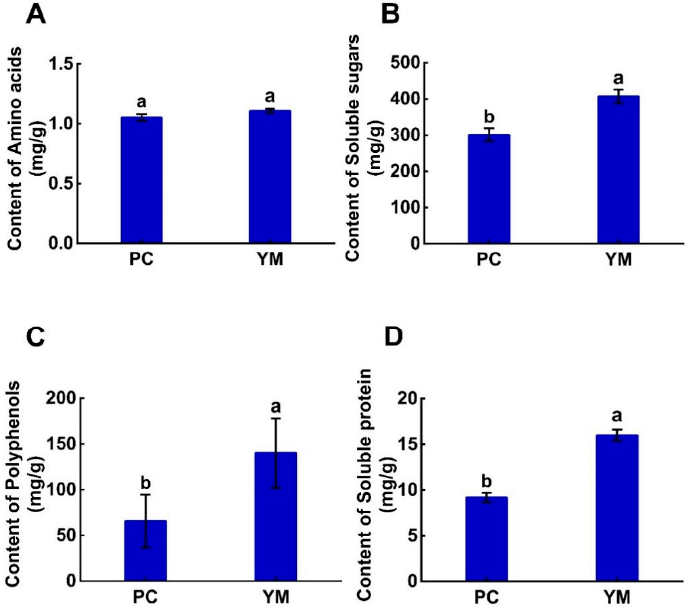
Figure 2. The analysis of primary metabolites in the ray florets of PC and YM. The content of amino acids ( A ), soluble sugars ( B ), polyphenols ( C ), and soluble protein ( D ) in ray florets of PC and YM. Different letters indicate significant differences at p < 0.05 according to Duncan’s multiple range test.